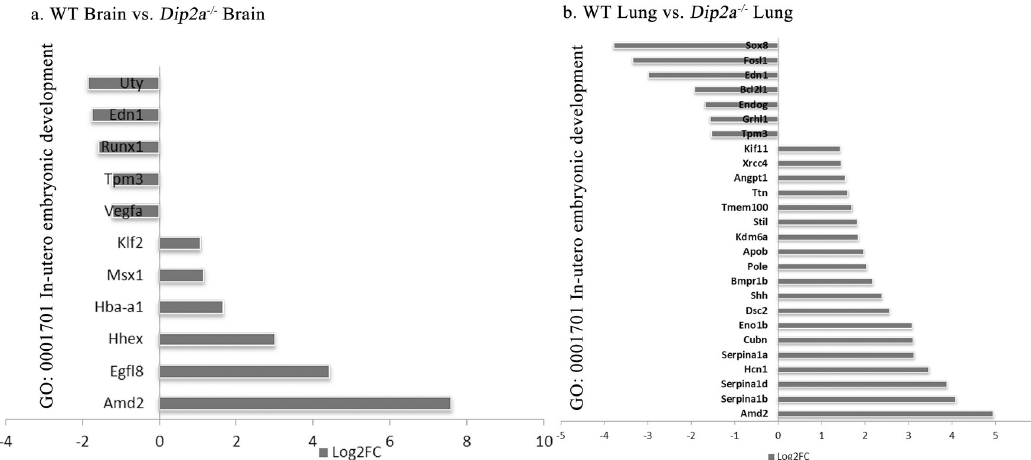
Fig 4. List of DEGs annotated to GO term ‘ In-utero embryonic